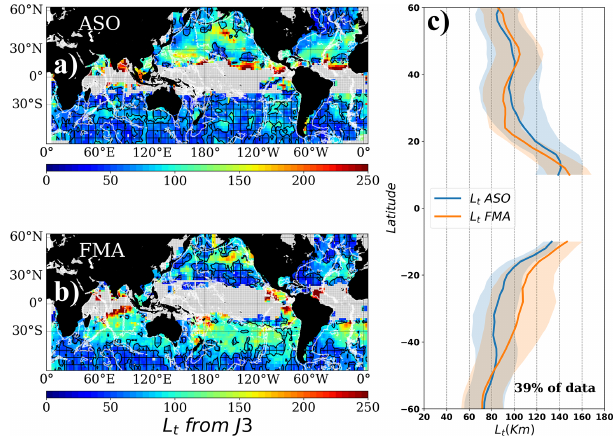
Figure 10. Intercept scale (in km) averaged during (a) August– September–October and (b) February–March–April for Jason-3. Shaded and hatched areas correspond to regions where the intercept scale is smaller than the local observable wavelength (signal-to- noise ratio equals 1). Blank areas in (a) and (b) correspond to the re- gions where the observed PSD is accounted for using a single-slope approach. (c) Zonal averages of the non-masked areas of (a) and (b) , but only considering the pixels where the observations of (a) and (b) are different at 95% confidence. The percentage of data that meets this criterion is also indicated. White contours in (a) and (b) repre- sent the topography at 3000m depth.